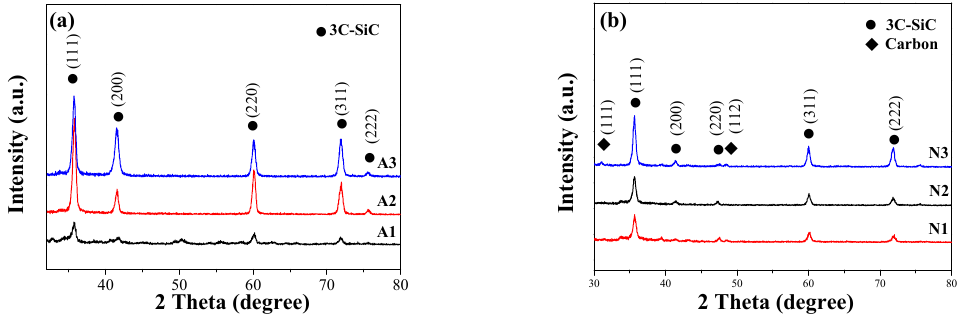
Figure 3. X-ray diffraction (XRD) patterns of SiC nanowires prepared with ( a ) Al 2 O 3 , ( b ) Ni catalysts.